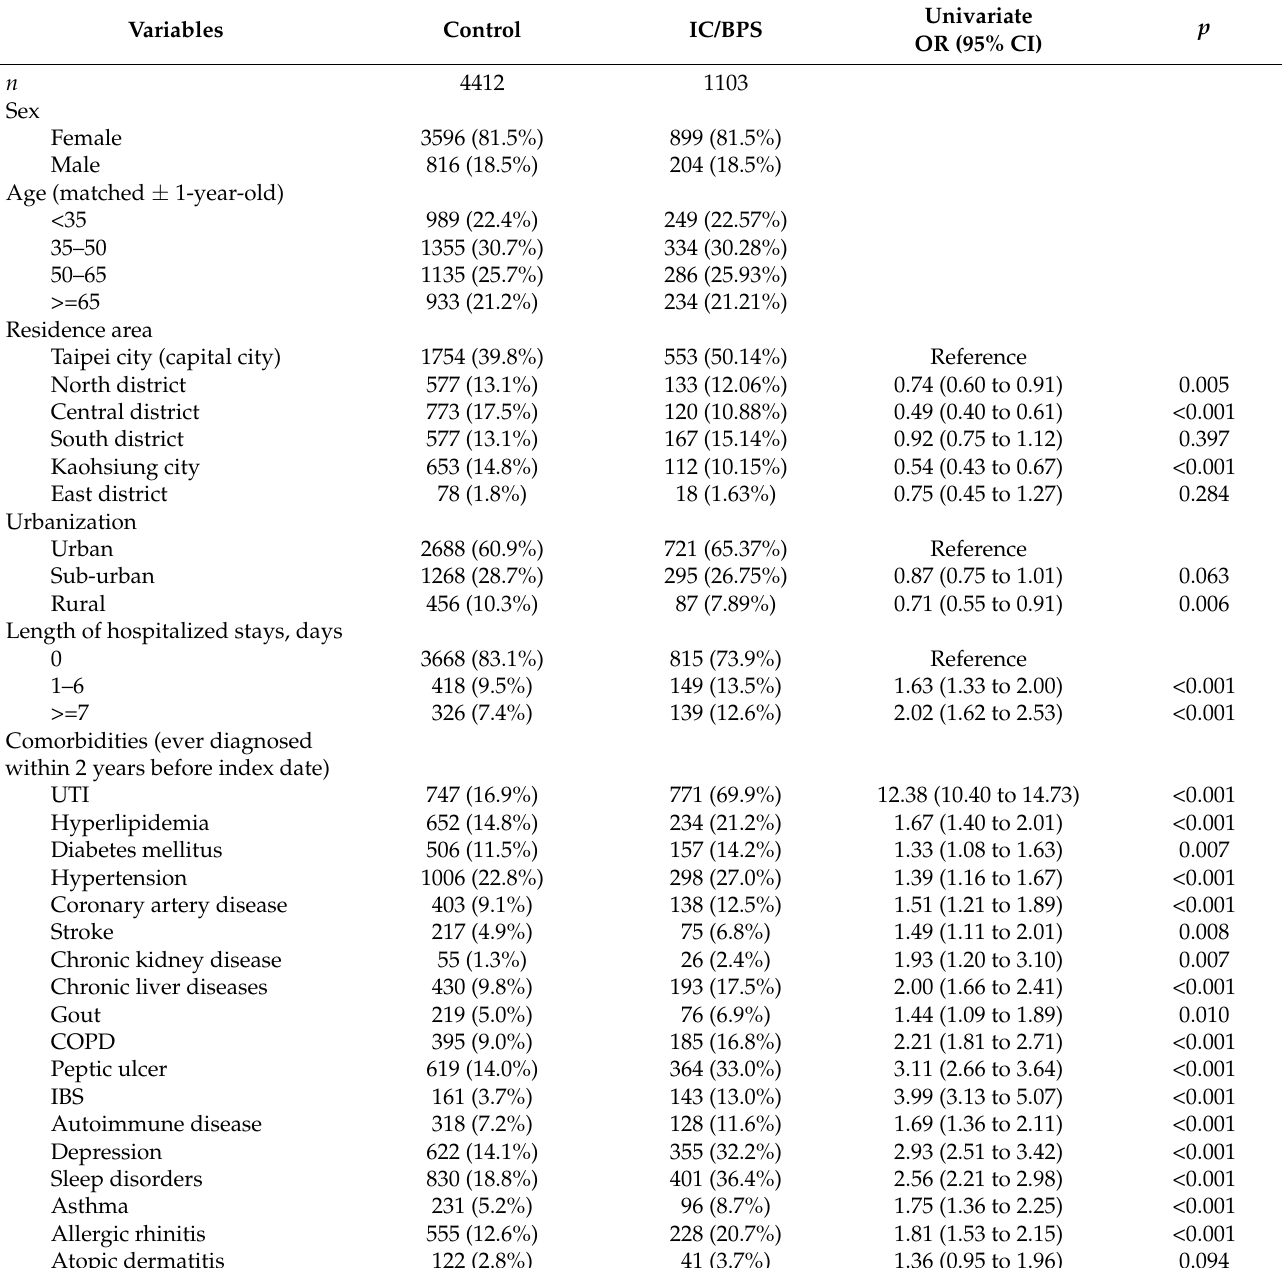
Table 1. Baseline characteristics among study